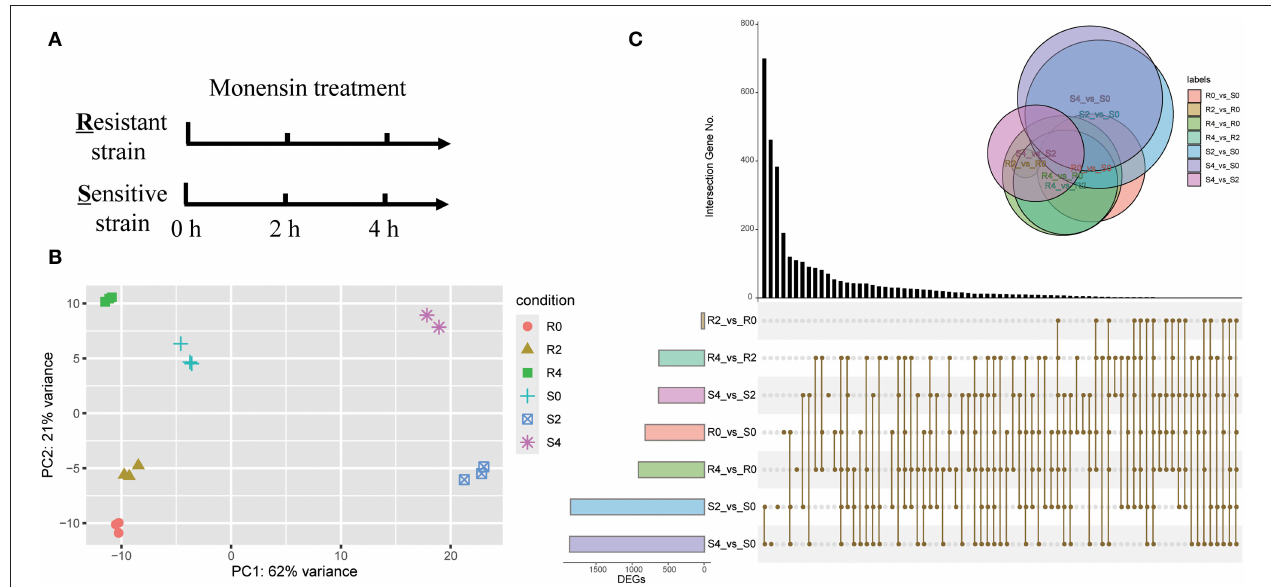
FIGURE 1 | Overview of RNA-seq analysis. (A) Diagram showing the monensin treatment and sampling strategies. Fresh sporozoites of E. tenella -sensitive strain (S) and -resistant strain (R) were treated with 5 µ g/ml monensin for 0, 2, and 4h, respectively. Total RNAs were then subjected to RNA-seq. (B) PCA of all RNA-seq samples. (C) An upset-plot showing sets of differentially expressed genes after monensin treatment. Vertical bars show the number of intersecting genes between the comparison groups, denoted by the connected brown dots below the histogram. Horizontal bars show the size of DEGs between the comparison groups. The Venn diagram shows the size and overlapping situation of DEGs in the different